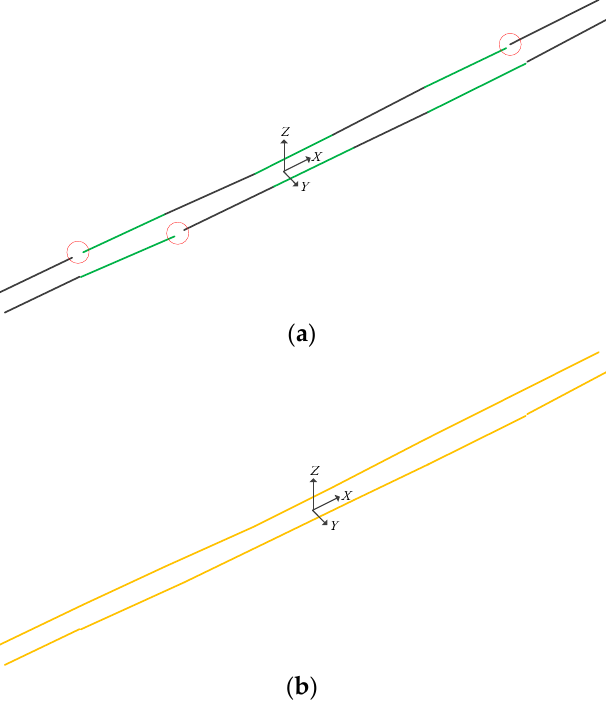
Figure 9. The connection result of all segmented rail lines. ( a ) Before connection; ( b ) After connection.